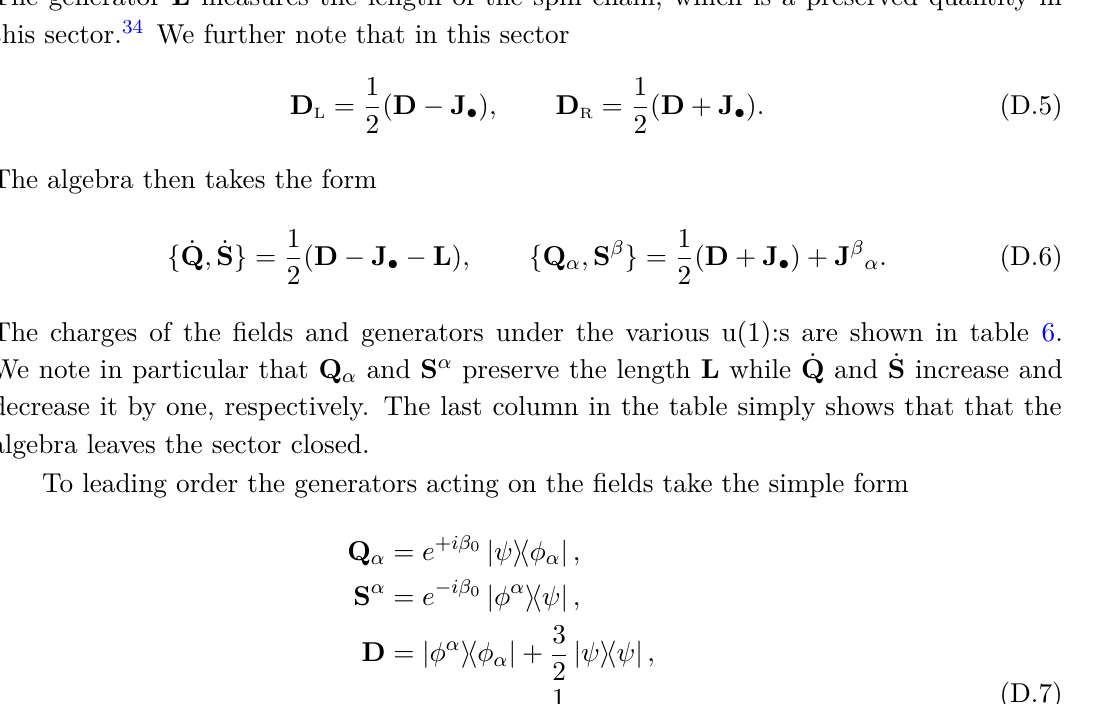
The generator L measures the length of the spin chain, which is a preserved quantity